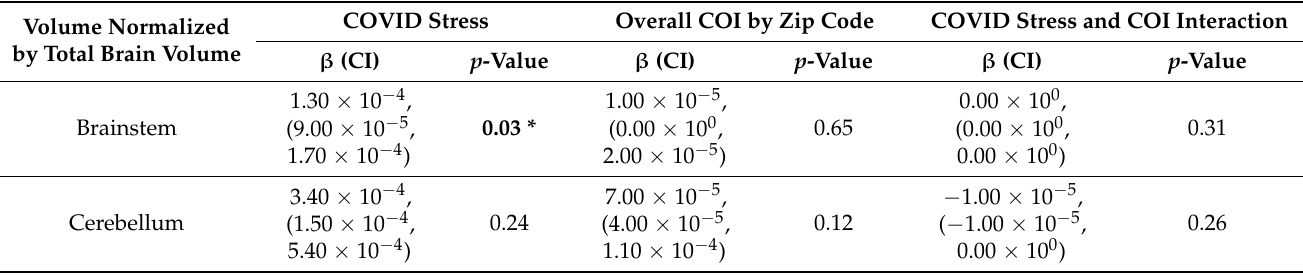
Table 3. Brain structure volumes’, after normalization to total brain volume, relationship to COVID stress, COI-SEE, and their interaction. * denotes statistically significant